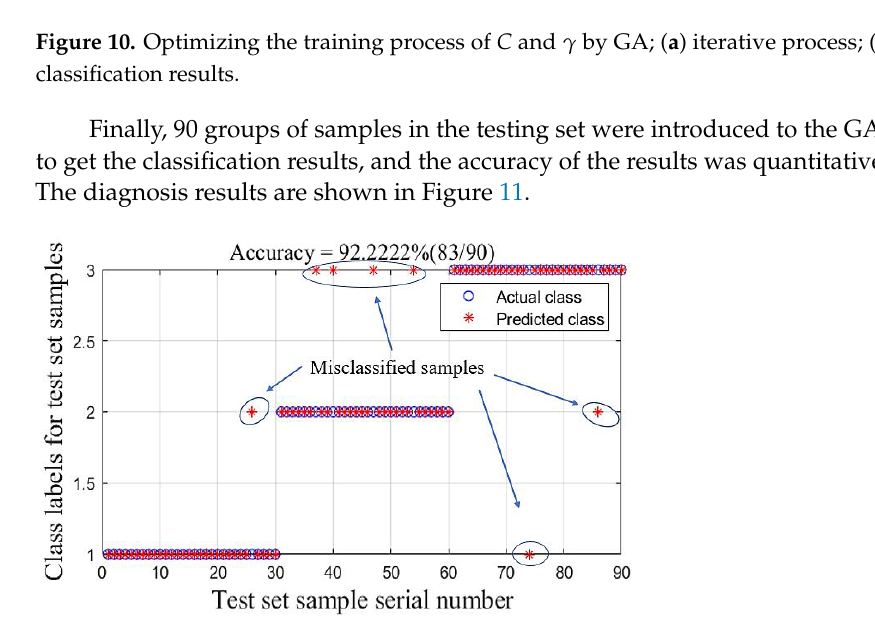
Figure 11. Classification results of rotor faults by GA-SVM model.